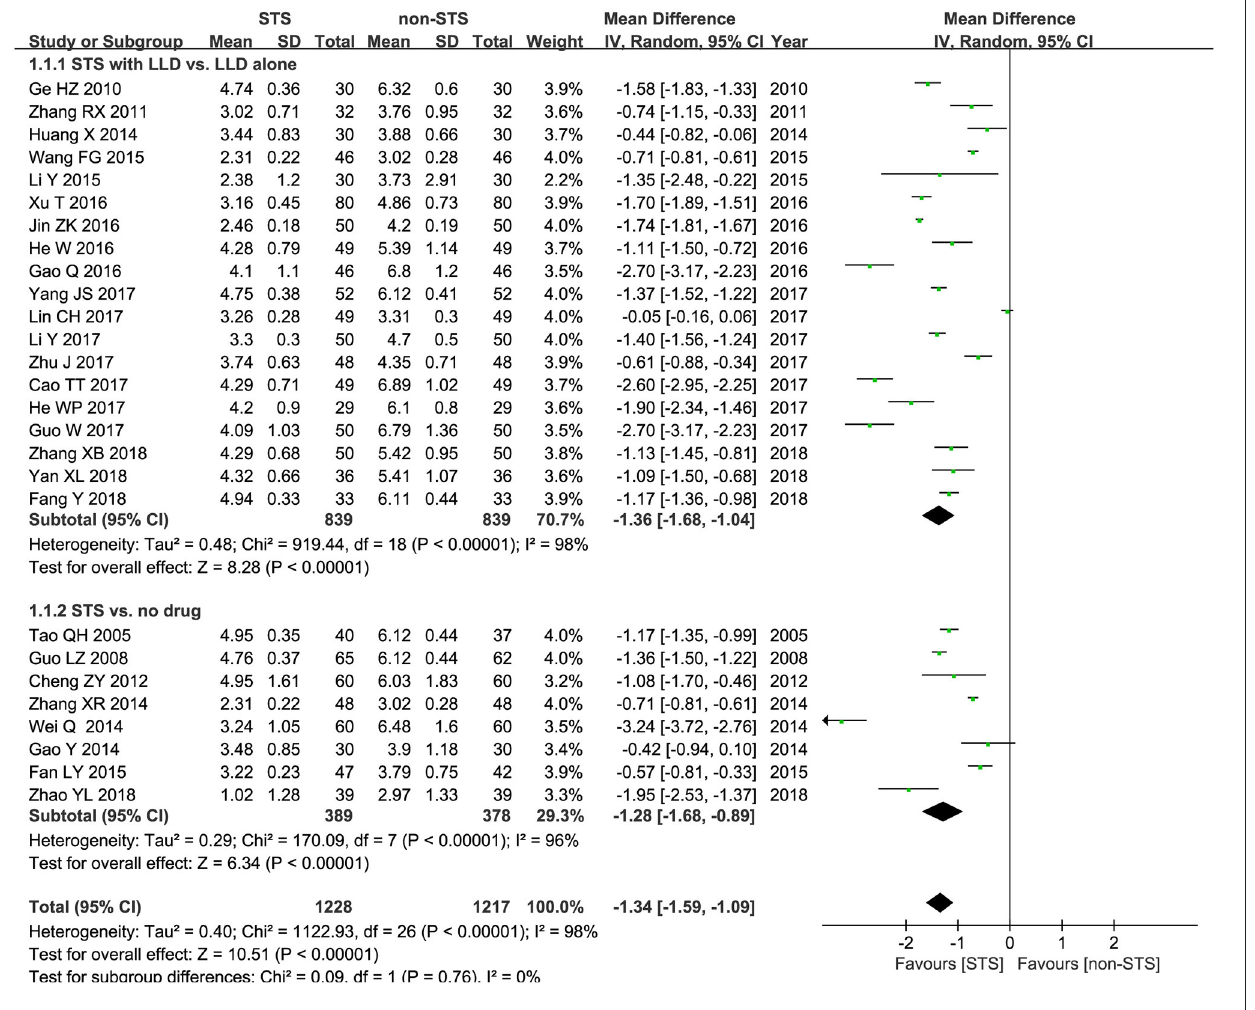
TG : As shown in Figure 4 , pooled results of 26